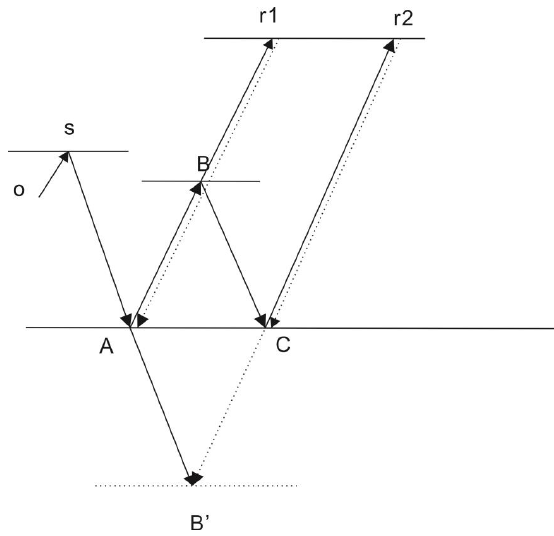
Figure 1. The path of internal multiple and the generation of image artifacts. The nth-, (n + 1)th- and (n + 2)th-order internal multiples follow the path of o-s, s-A – B – r1, and B-C-r2. The nth-order internal multiple generates the (n + 1)th-order internal multiple, and the (n + 1)th-order internal multiple generates the (n + 2)th-order internal multiple. The dashed line r1-B-A and r2-C- B’ represents the path of backward-propagated wavefield of the (n + 1)th-order internal multiple and (n + 2)th-order internal multiple, respectively.